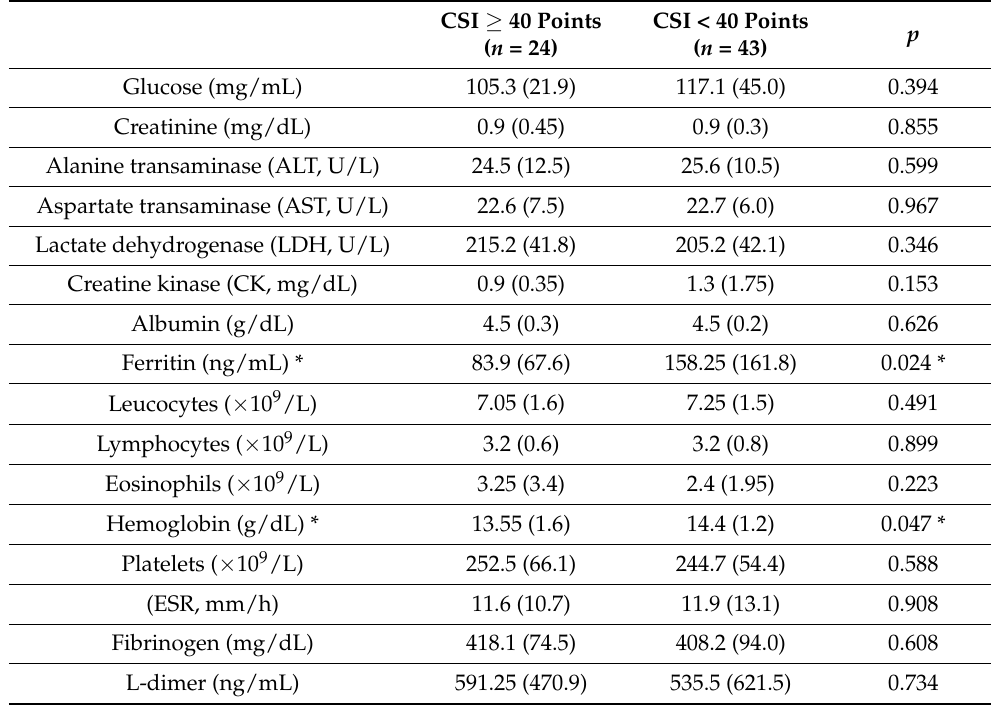
Table 1. Laboratory biomarkers of COVID-19 patients according to the presence or absence of sensitization-associated